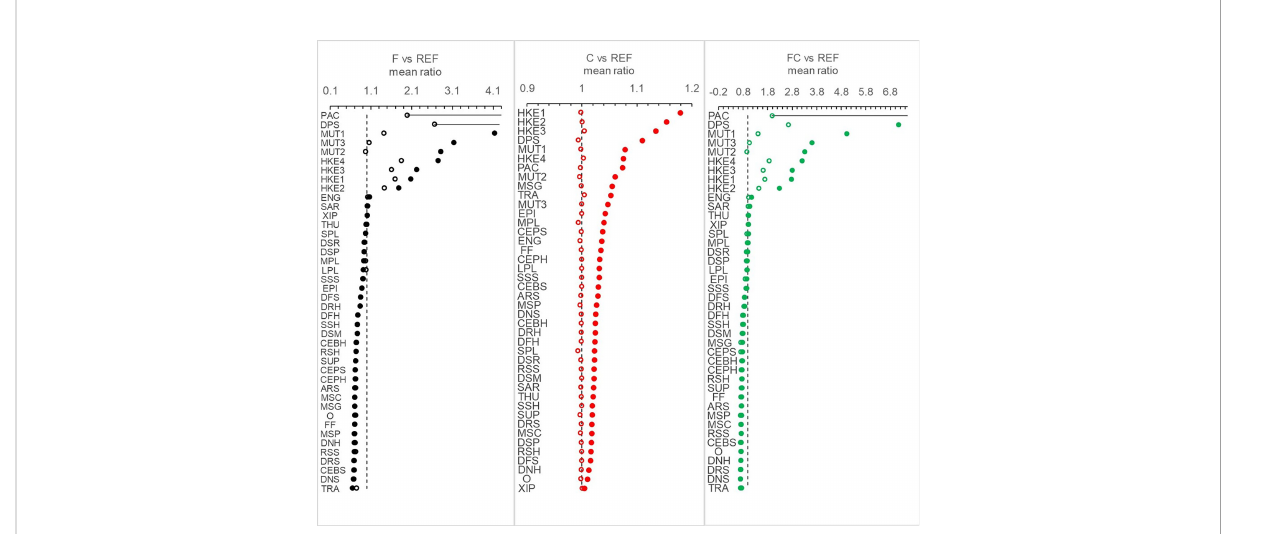
FIGURE 5 Mean ratio of landings per functional group calculated between the alternative scenarios (F, C, FC) and the reference (REF) in the years 2026- 2030 and 2046-2050.